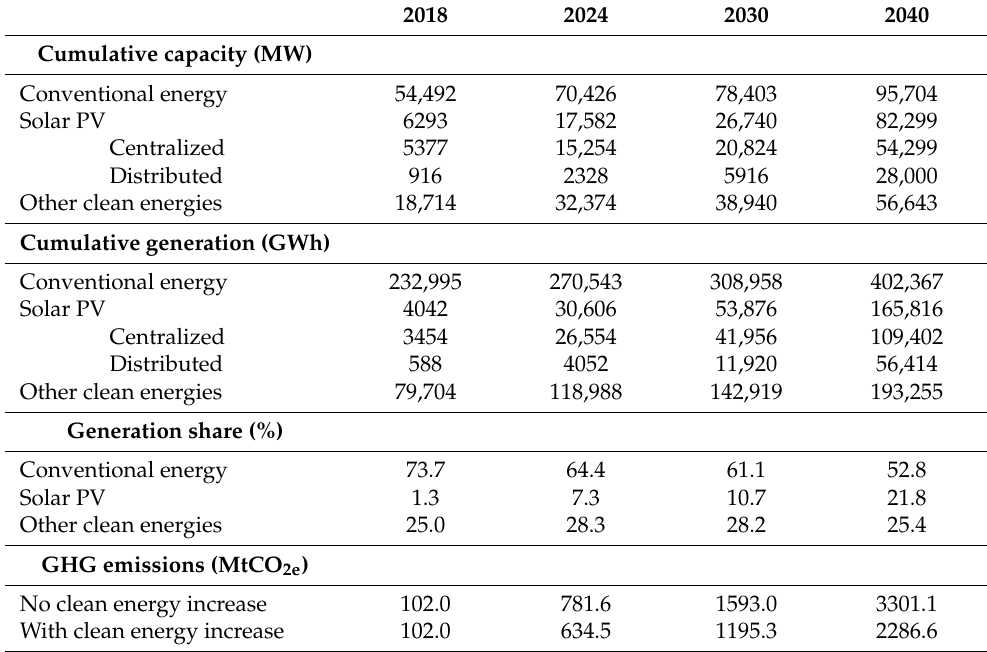
Table 6. Installed capacity, electricity generation and GHG emissions based on national perspectives, 2018–2040.